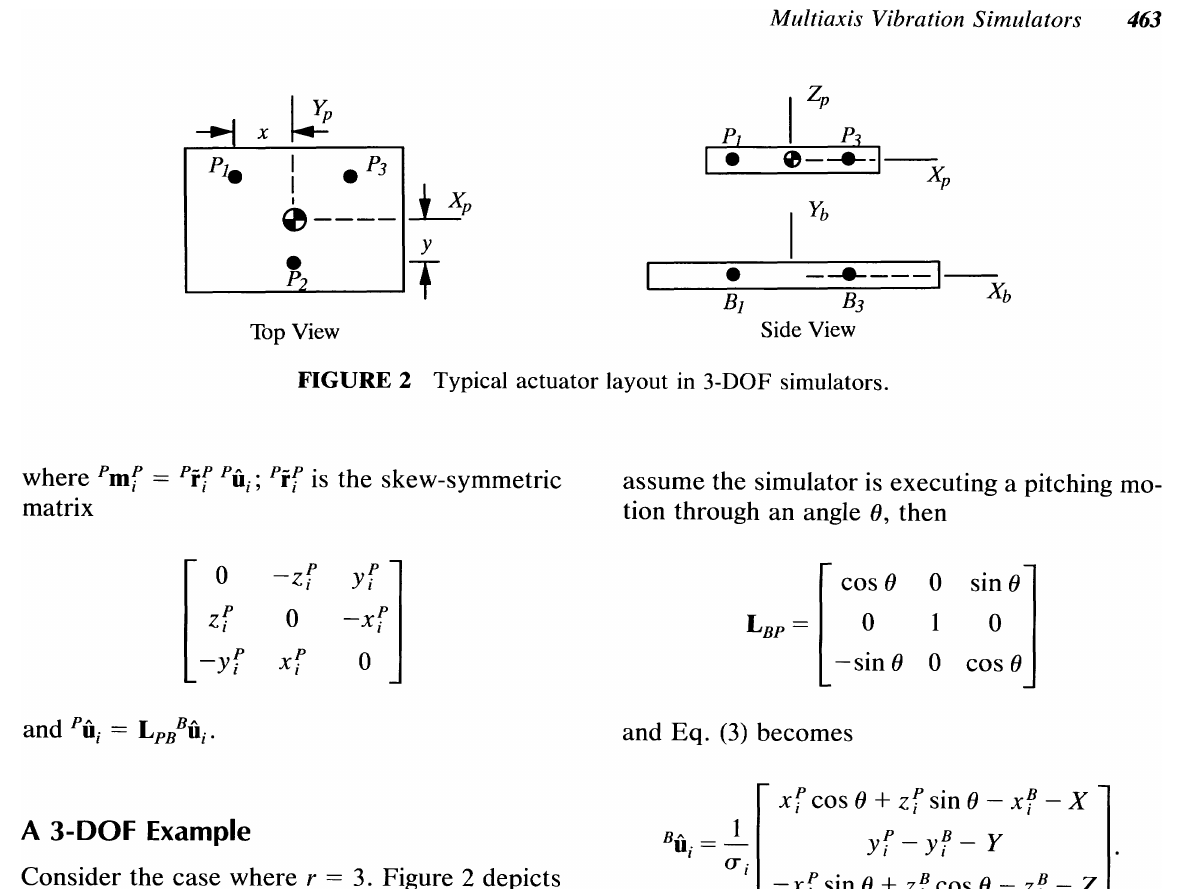
FIGURE 2 Typical actuator layout in 3-DOF simulators.